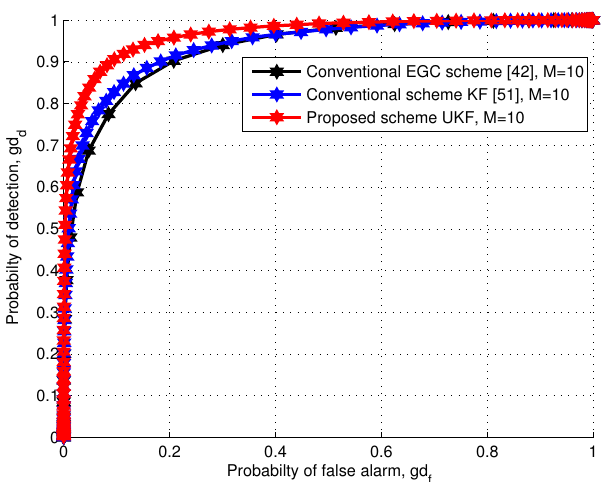
Figure 9. Detection gain comparison between an equal gain combining (EGC), Kalman filter (KL) and unscented Kalman filter (UKF) with different numbers of CUs, i.e., M = 10 and signal to noise ratio